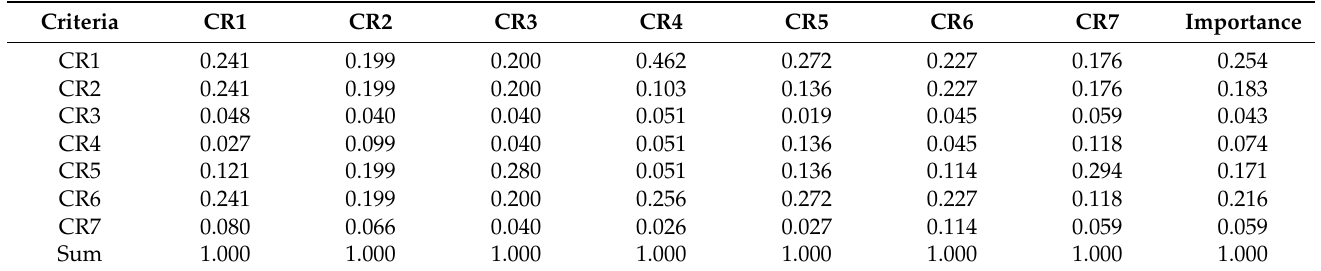
Table 2. Standardization of importance table.